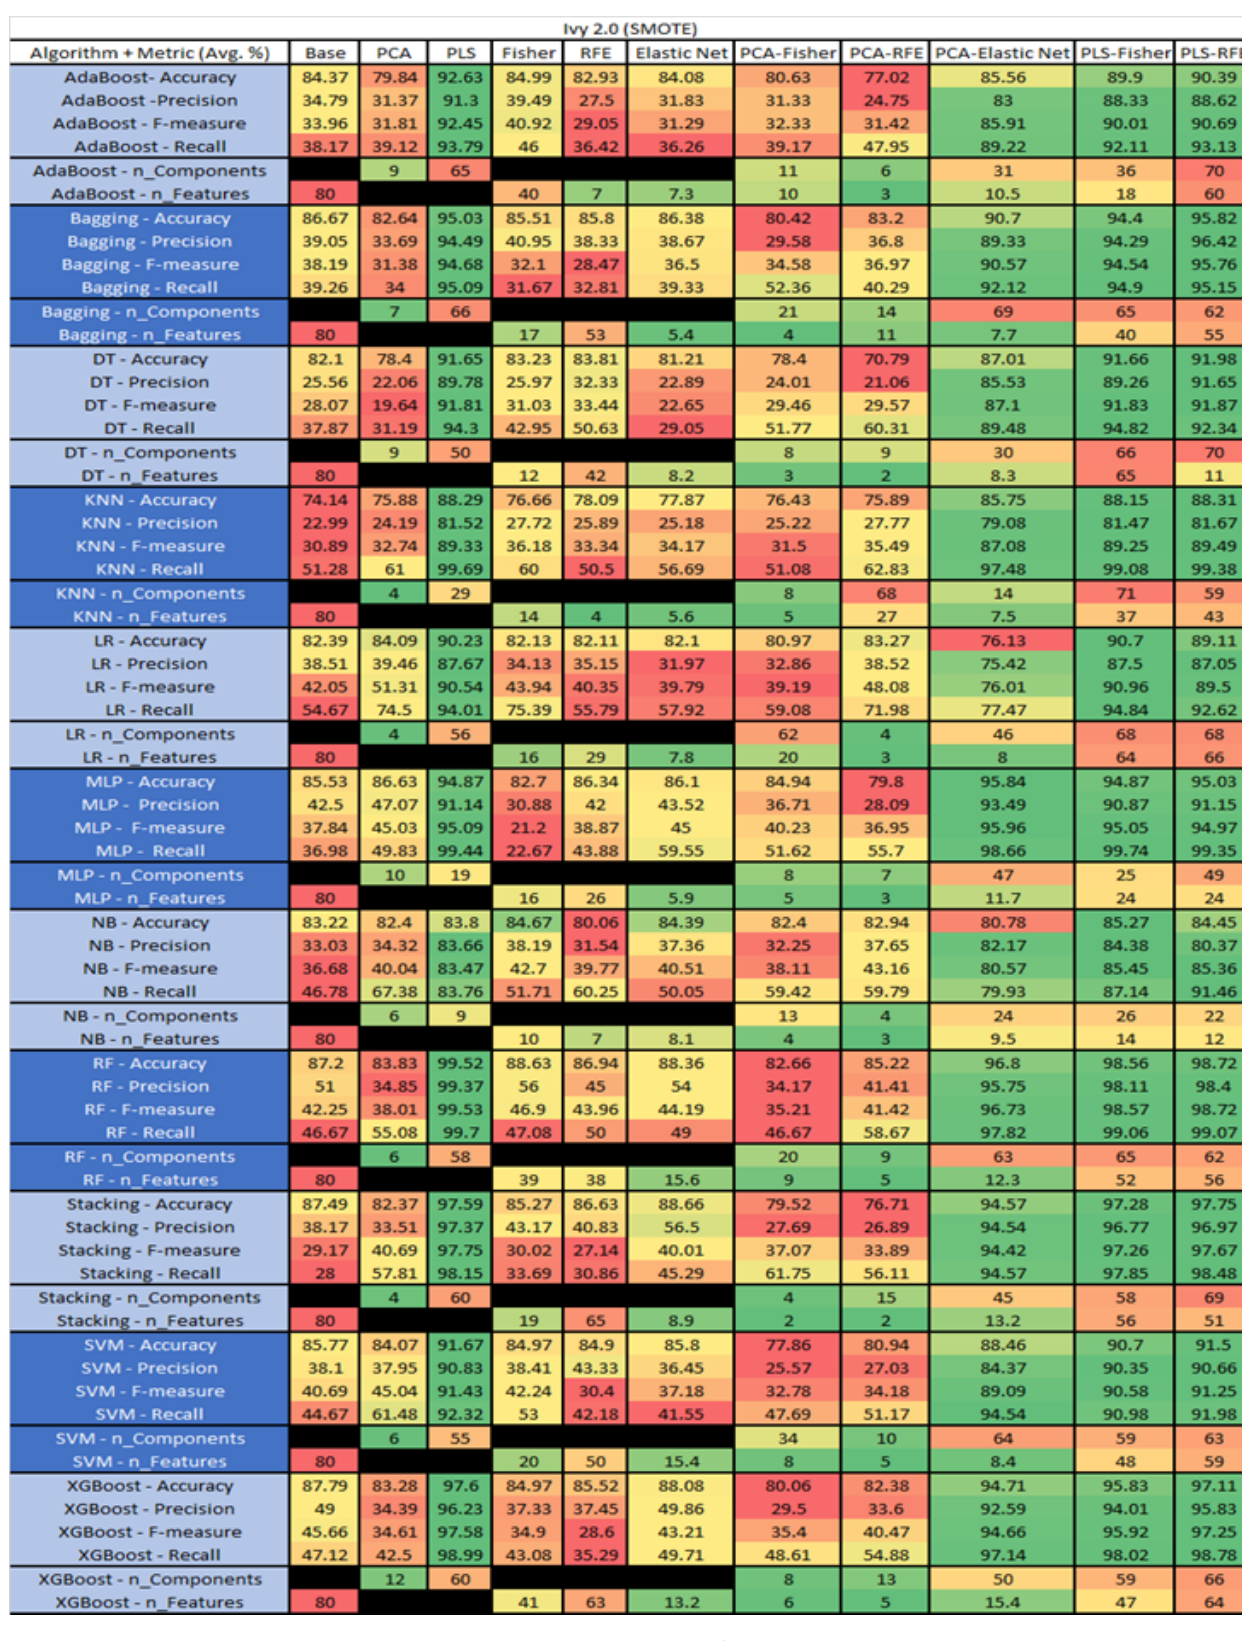
Figure 21. Ivy 2.0 SMOTE PROMISE Results Data